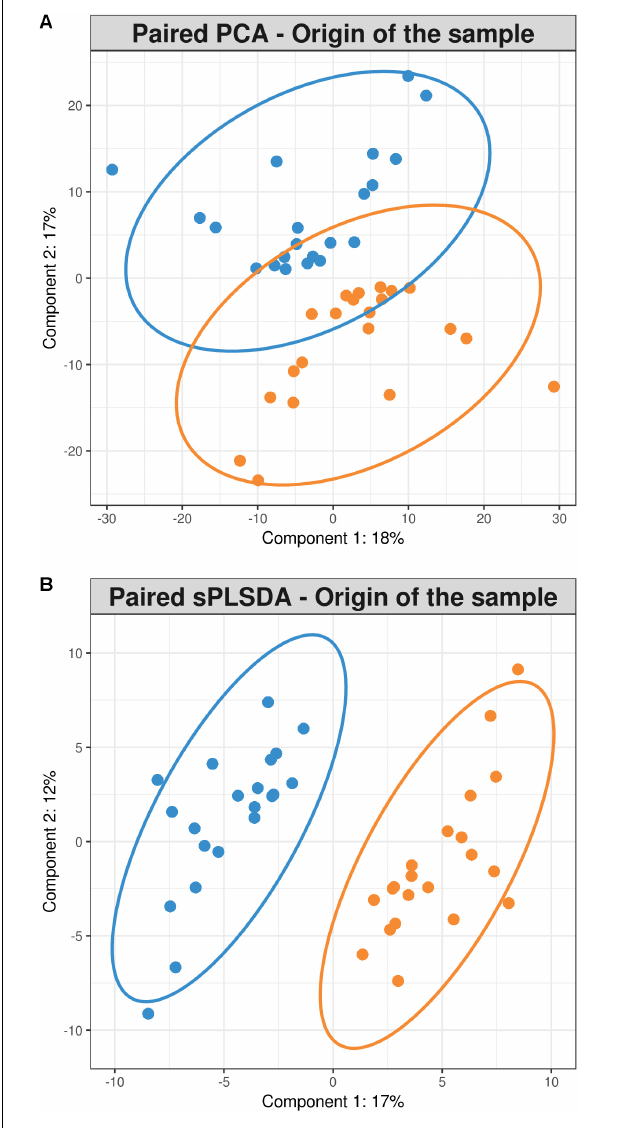
FIGURE 3 | (A) Paired samples principal component analysis (B) Paired samples sparse partial least squares discriminant analysis representing 21 cecum (blue) and 21 feces (orange)